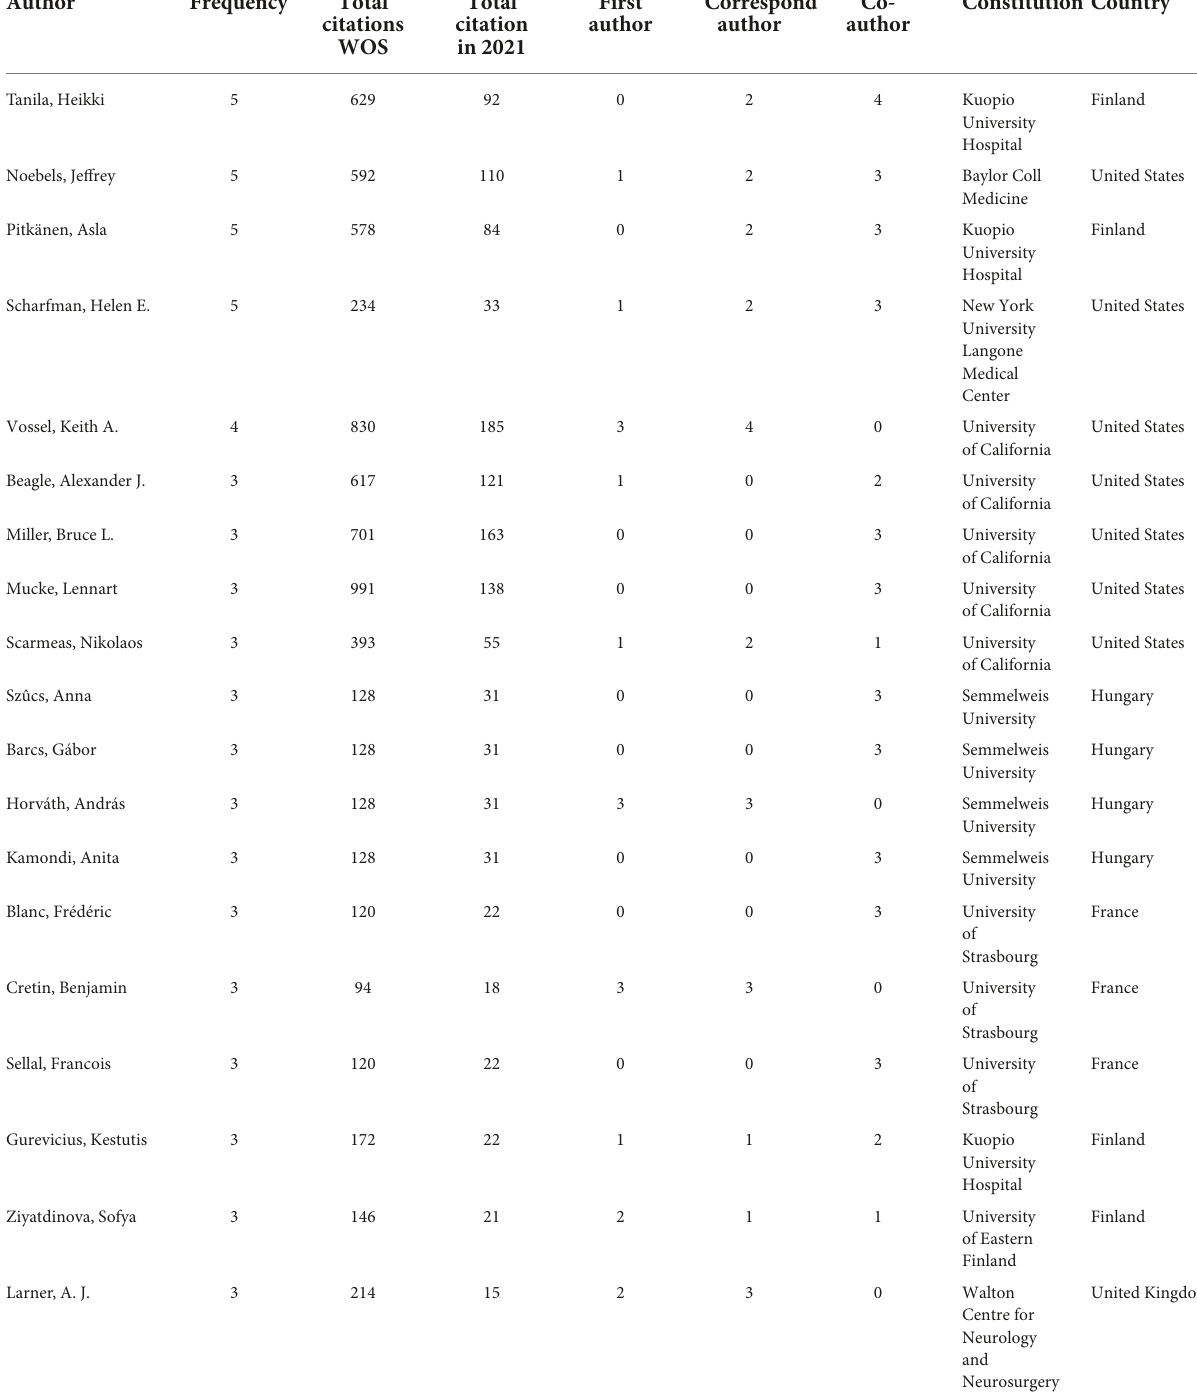
TABLE 5 Major contributing authors in the top 100 most-cited